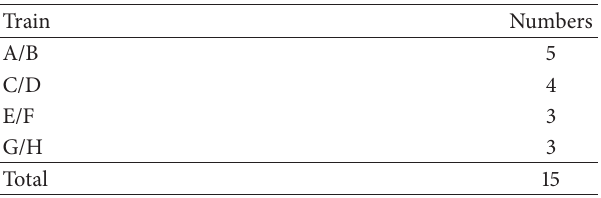
Table 1: Number of concrete core-drilled sample.